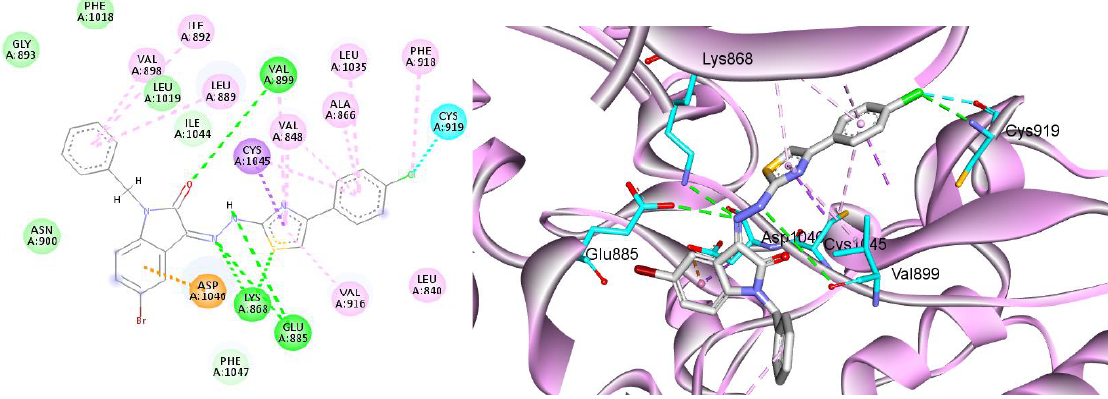
Figure 4. 2D and 3D interactions of compound 7d with the VEGFR2 active binding site.